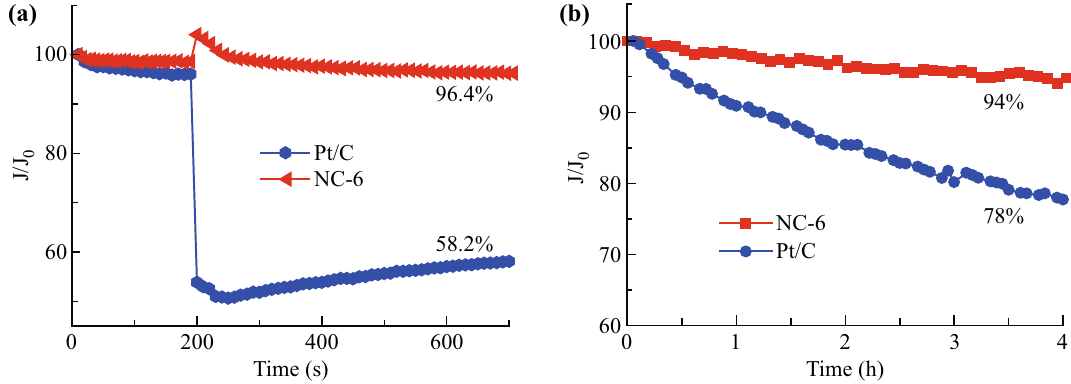
Fig. 8 a Chronoamperometric responses of the NC-6 and Pt/C electrodes in 0.1 M KOH solution with 3 M methanol added after * 5 min at a rotation rate of 1600 rpm. b Chronoamperometric curves of NC-6 and Pt/C electrodes at 0.4 V (vs. RHE) in O 2 -saturated 0.1 M KOH